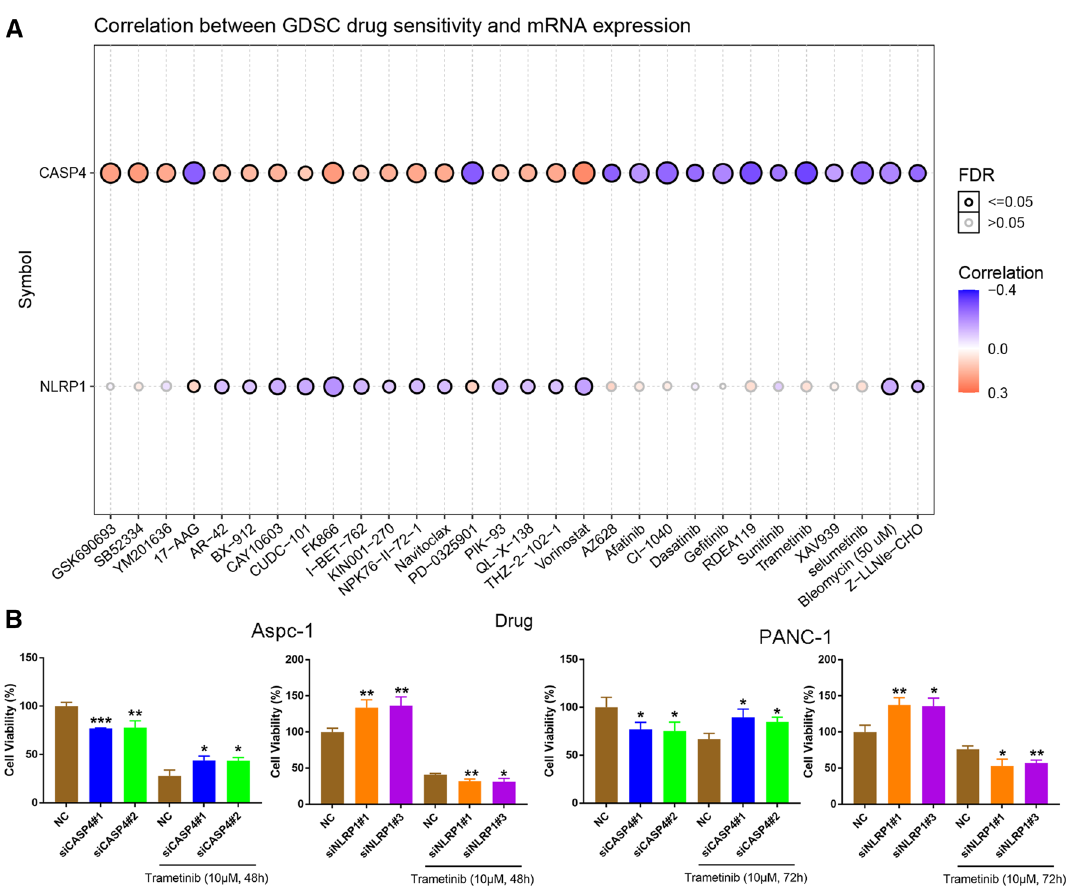
Fig. 10 Analysis of drug sensitivity associated with PEGs. A Correlation of CASP4 and NLRP1 expression with multidrug sensitivity in GDSC. Red is positive correlation, which means the higher the gene expression, the more sensitive to the drug, while the blue is the opposite. The Spearman correlation represent the gene expression correlates with the drug. The positive correlation means that the gene high expression is resistant to the drug, vise verse. B Survival rate of cells exposed to trametinib at the concentrations of 10 µM/L for 48 or 72 h (*P < 0.05, **P < 0.01, ***P <